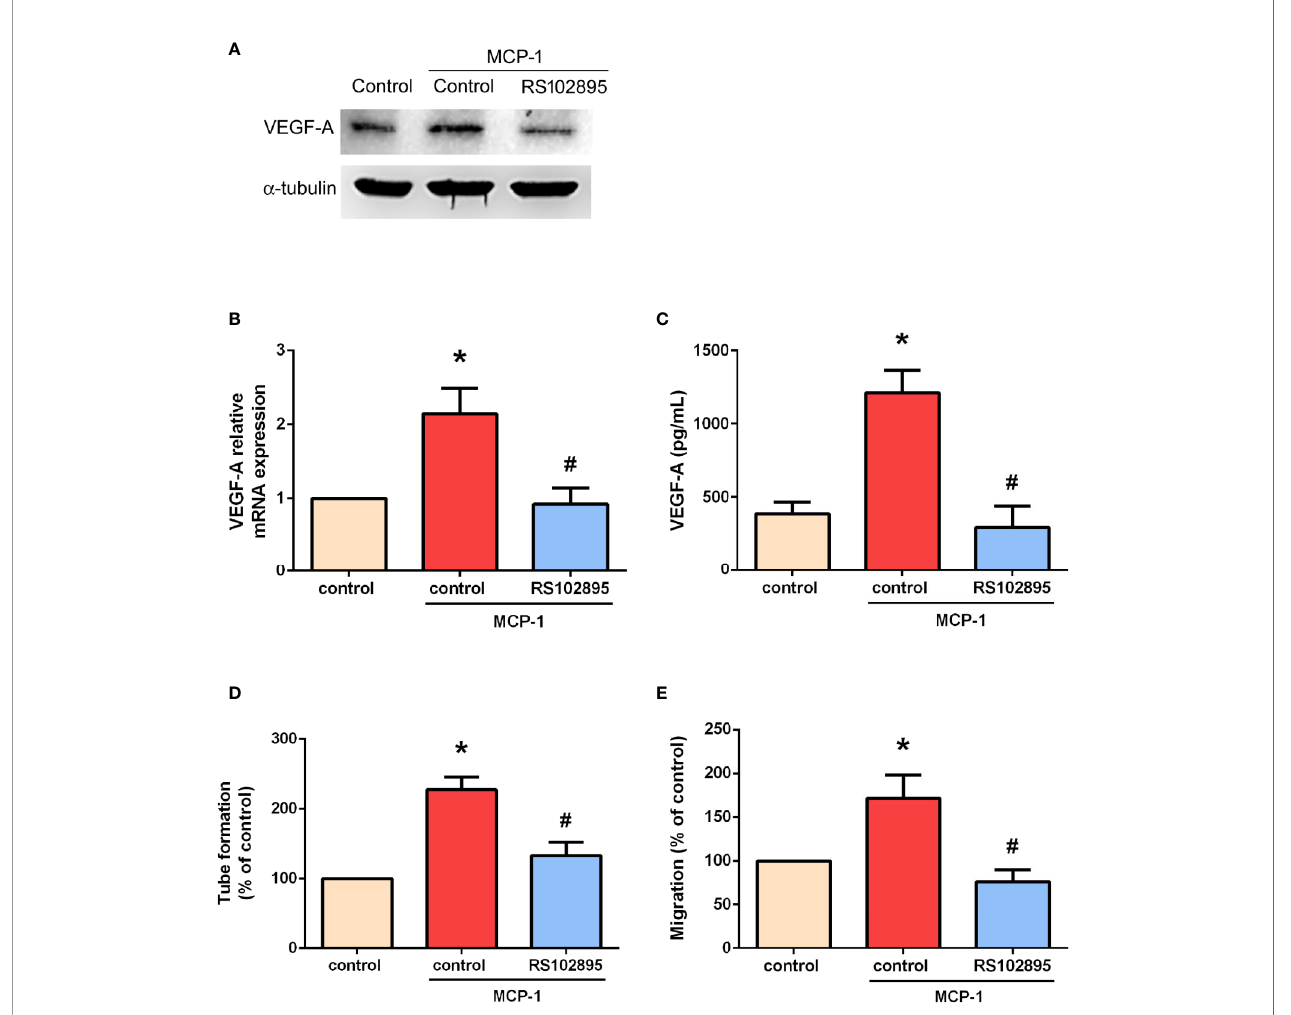
FIGURE 3 | MCP-1 promotes VEGF-A expression andangiogenesis via the CCR2 receptor.Cellsweretreatedwith a CCR2 antagonist (RS102895; 100 ng/ml)for 30 min andthen stimulated with MCP-1 (50 ng/ml)for 24 h. VEGF-A expression was measured by Westernblot (A) , RT-qPCR (B) , and ELISA assays (C) . Cells were treated with RS102895 (100 ng/ml) for 30 min andthen stimulated with MCP-1 (50 ng/ml) for 24 h,then CM was collected. After treating the EPCs with CMfor 24 h, capillary-like structure formation was examined using the tube formation assay (D) and cellmigration was examined with the Transwellassay (E) . * p < 0.05 compared with controls; # p < 0.05 compared with MCP-1 – treated controls. Each experimental procedure was independently repeated three times, with